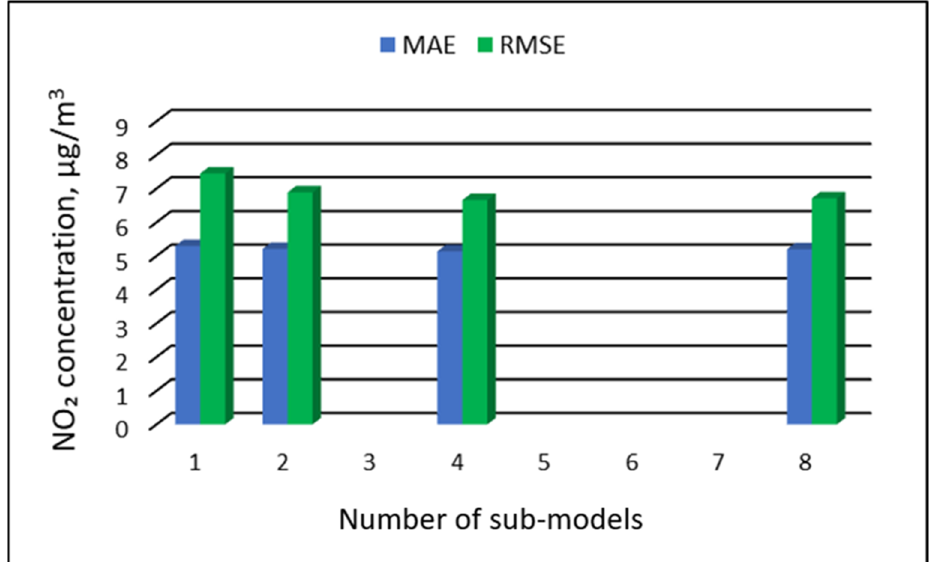
Table 12. Values of approximation errors of NO 2 concentrations in PVS models, Z ł oty Potok 2011– 2016.